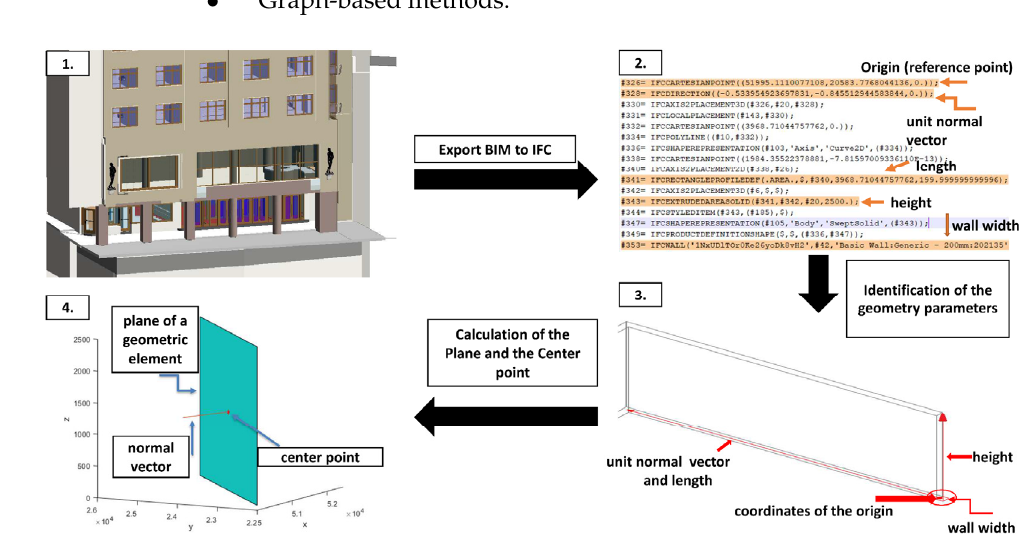
Figure 3. Identification of geometry from BIM model—( 1 ) BIM model, ( 2 ) IFC file ( 3 ) derivation of the wall’s geometry, ( 4 ) estimation of the parameters of the wall’s surface.